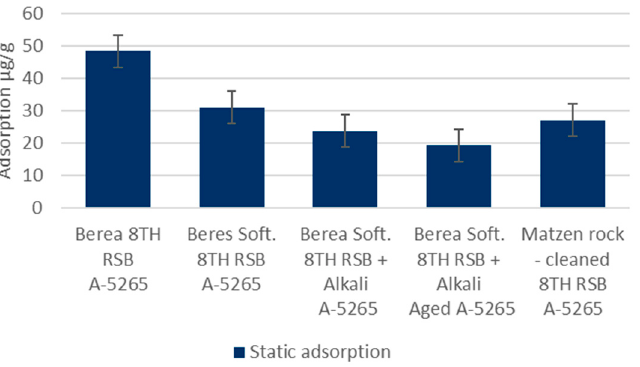
Figure 5. KemSweep A-5265 static adsorption in different conditions in crushed Berea and